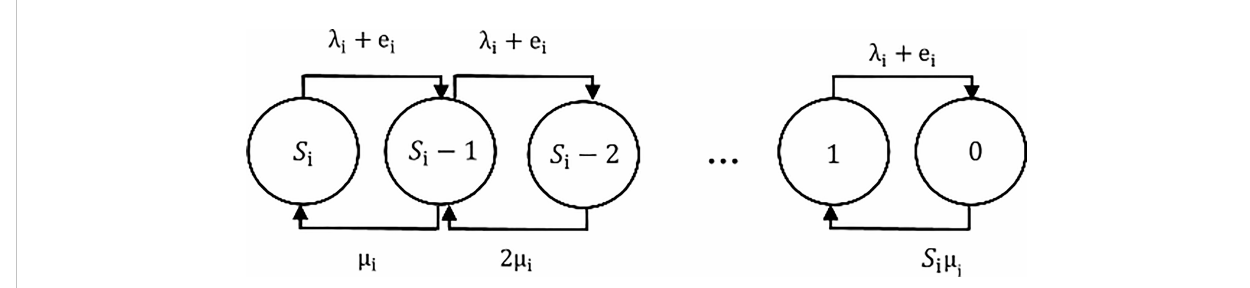
FIGURE 4 Change of empty-container storage in port i under the complete-repositioning